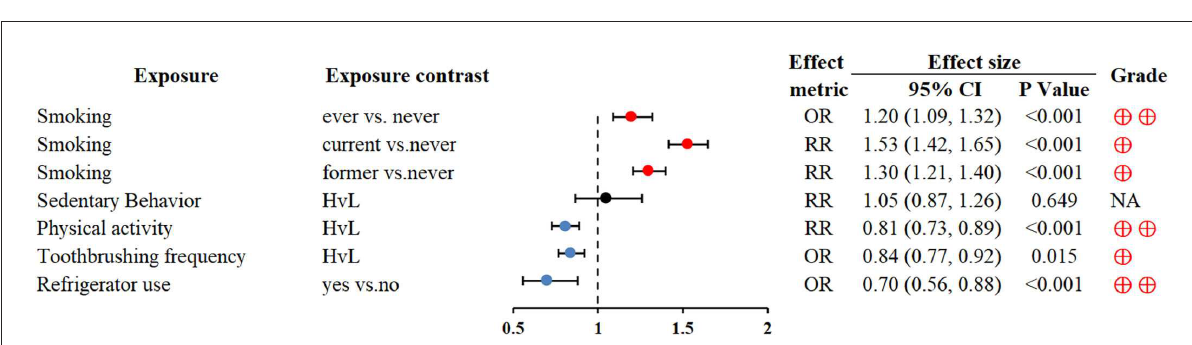
FrontiersinPublicHealth